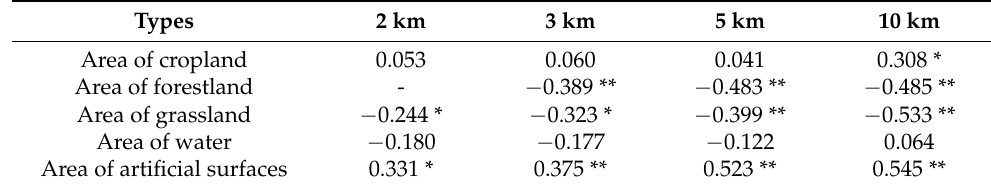
Table A1. Correlation coefficients between the area of each land type and PM 2.5 concentration at different buffer radii. The missing value is attributed to insufficient data on the area of forestland within a buffer zone of 2 km.